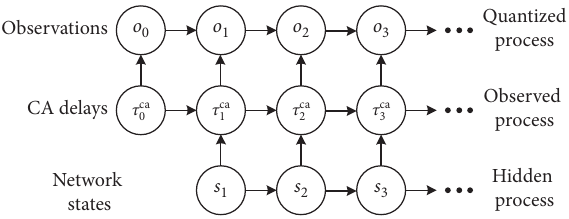
Figure 4: DCHMM-based delay